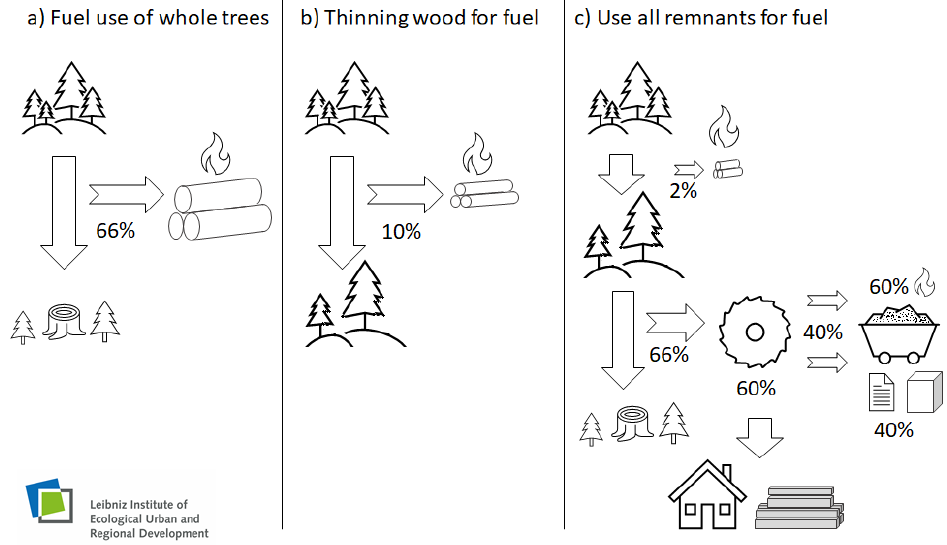
Figure 1. Several types of supply, from wood to fuel, with their average yields and shares (source: authors): ( a ) use of the heartwood of entire trees for fuel, ( b ) use of only the thinning wood for fuel, while the rest is used materially, ( c ) use of the forestry and saw-mill by-products for fuel. These various proportions must be applied to the annual increment in German forests, which amounts to 121.6 million m 3 on 11.3 million ha of the forest area, corresponding to an average of 10.8 m 3 per ha and